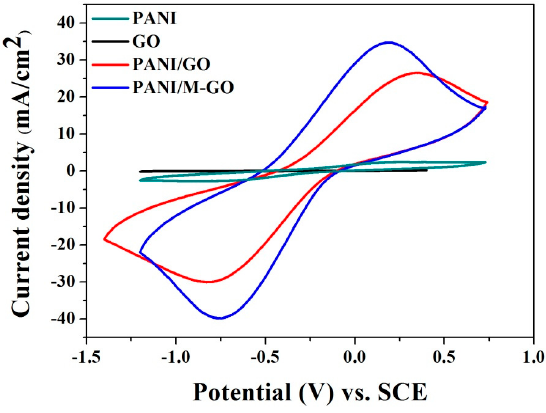
Figure 4. CV curves of PANI, GO, PANI/GO, and PANI/M-GO composite electrode in 1 M H 2 SO 4 at 50 mV/s.